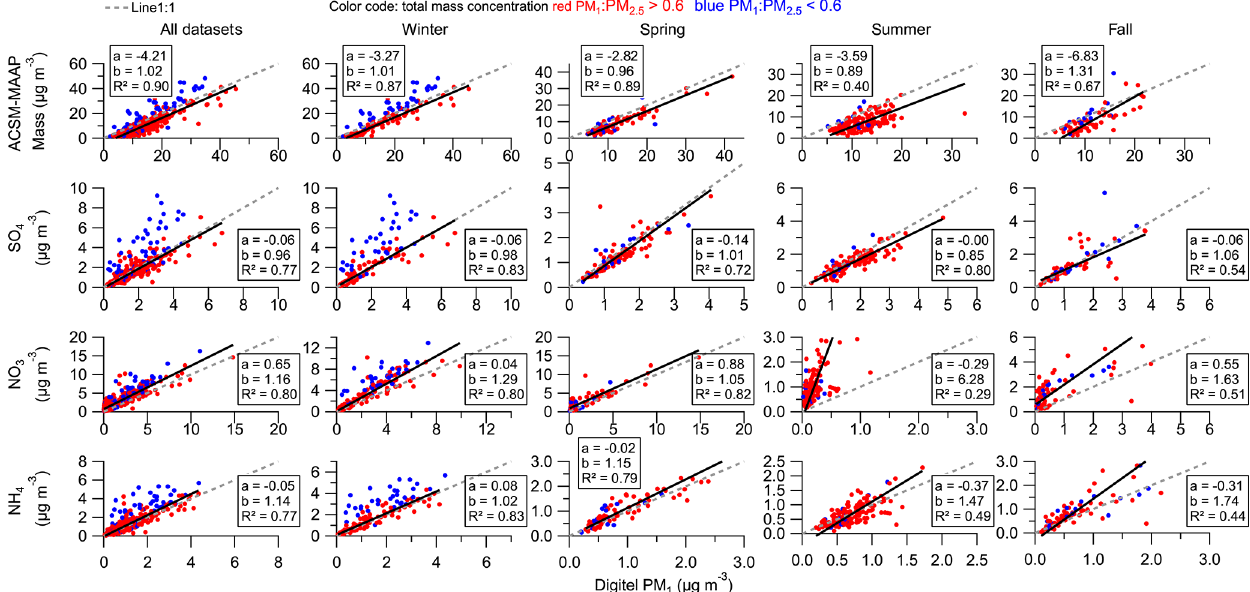
Figure 2. Seasonal variability in the comparison between online and offline PM 1 aerosol measurements. The color coding indicates whether the ratio PM 1 :PM 2 . 5 total mass concentration is above (red) or below (blue) the selected threshold value of 0.6 (see discussion in Sect. 3.1.1.). Dotted grey lines show the line 1:1 and solid black lines represent regression fit by least-orthogonal-distance fit ( y = a + bx ). Please note the different axis ranges for the same